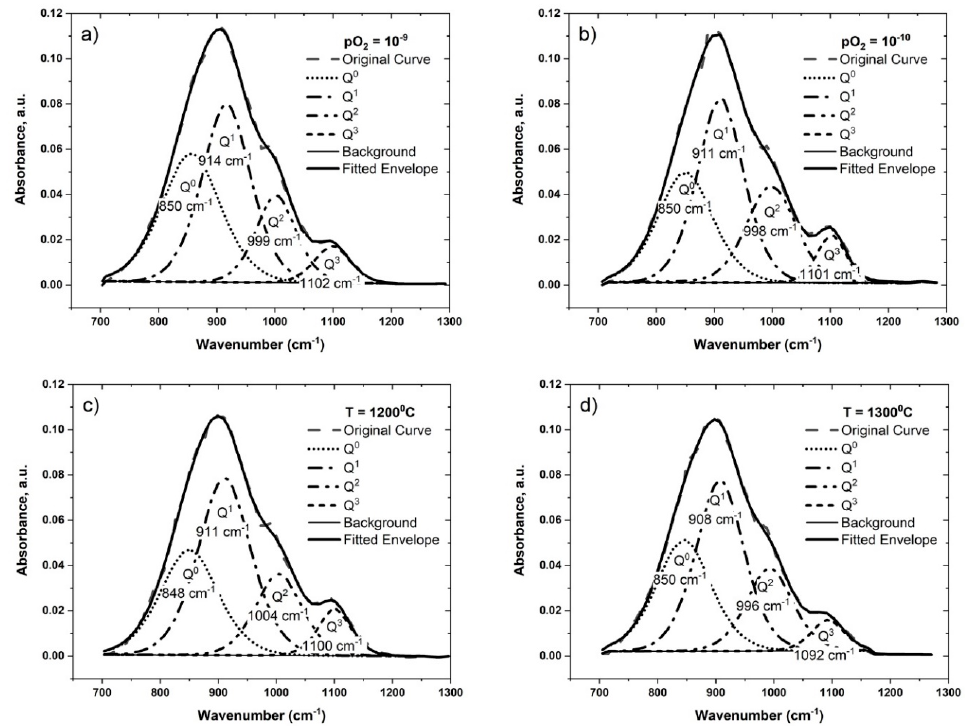
Figure 10. Deconvolution results of FTIR spectra of FCSM-Cu 2 O-PdO slags for samples equilibrated at ( a ) p O 2 = 10 − 9 , T = 1300 °C (1573 K); ( b ) p O 2 = 10 − 10 , T = 1300 °C (1573 K); ( c ) p O 2 = 10 − 8 , T = 1200 °C (1473 K); and ( d ) p O 2 = 10 − 8 , T = 1300 °C (1573 K).